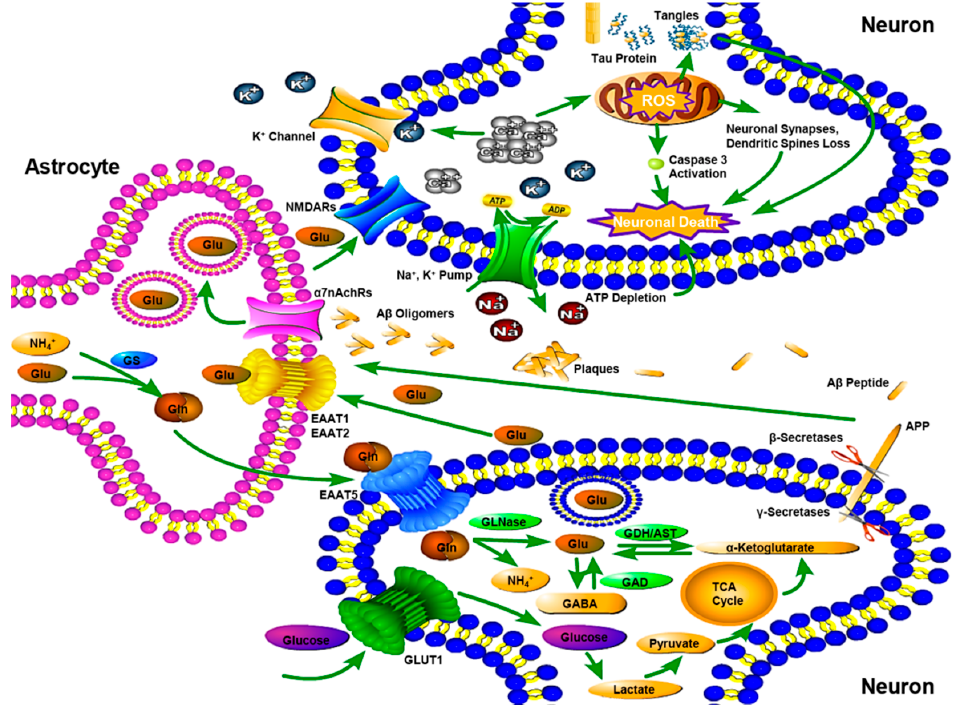
Figure 1. Mechanism of Amyloid hypothesis, Tau hypothesis and Glutamine-Glutamate cycle in an Alzheimer’s disease (AD) brain. In the presynaptic neuron, mutational amyloid precursor protein (APP) located in cell membrane is cleaved by β - and γ -secretases, produces excess A β peptides, which promote production of A β oligomers. Excess neuronal A β oligomers flow onto surrounding astrocytes to bind with α 7nAChRs. The signals from α 7nAChRs result in astrocytes’ glutamate exocytose to activate the extrasynaptic N -methyl- D -aspartate receptors (NMDARs) of the astrocytes’ partner neurons. The resulted signals evoke Ca 2+ surges and induce dysfunctional mitochondria with pumping out reactive oxygen species (ROS), which trigger a tau hyperphosphorylation, oxidative damage, caspase 3 activation, excess production of ROS, thereby severing communications within the astrocytes’ neurons and beyond and destroying neuronal synapses, dendritic spines. Consequently Ca 2+ surges increase in extracellular K + , which induces adenosine triphosphate (ATP) depletion, cell swelling and cell death. Abnormal phosphorylation of tau results in the transformation of normal adult tau into neurofibrillary tangles (NFTs) and disruption of the axonal form of microtubules. Glutamate released from presynaptic terminals transported via the excitatory amino acid transporter (EAAT) 1, 2 into astrocytes, where is transformed to glutamine by the glutamine synthetase (GS). Subsequently, the glutamine taken up by neurons is converted to glutamate and the synthesis of α -ketoglutarate and glutamate occurs, after which is then metabolized into Gamma-aminobutyric acid (GABA) by glutamate decarboxylase (GAD). AST, aspartate transaminase; EAAT 5, excitatory amino acid transporter 5; GDH, glutamate dehydrogenase; GLN, glutamine; GLNase, glutaminase; GLU, glutamate.